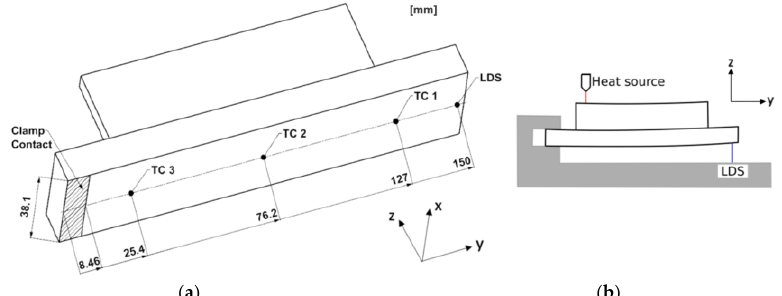
Figure 2. ( a ) Substrate and wall showing the location of the thermocouples (TC) and the laser displacement sensor (LDS) measurement at the bottom side of the substrate. ( b ) Sketch showing the position of the LDS distortion measurement.